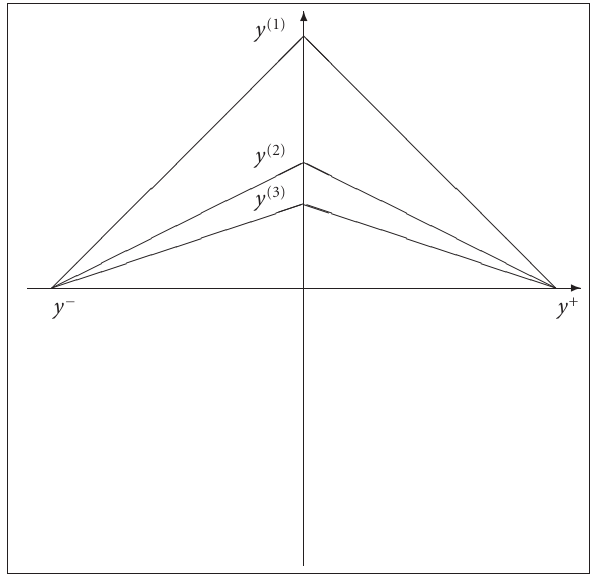
Figure 6.1. The subsets Y (1) , Y (2) , and Y (3) of the set Y